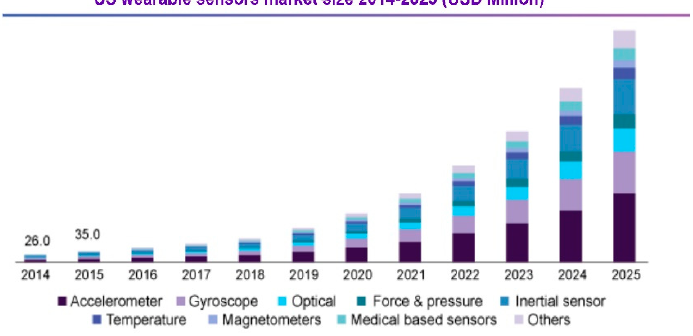
Figure 1. The expected increase in the value of the sensor market [16] .